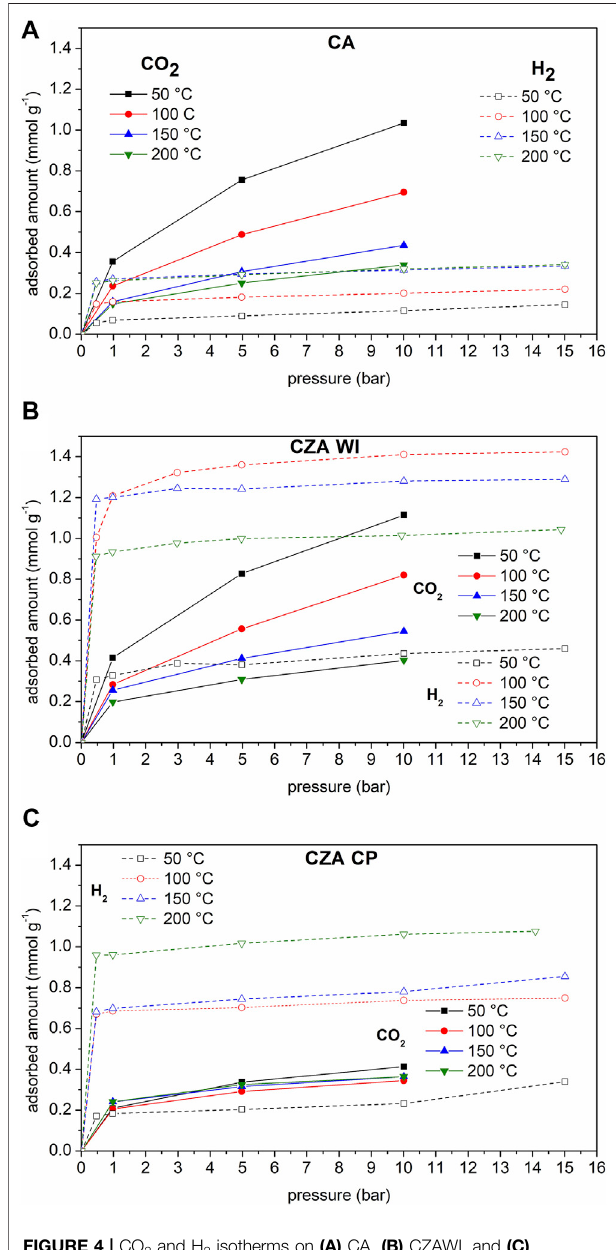
FIGURE 4 | CO 2 and H 2 isotherms on (A) CA, (B) CZAWI, and (C)